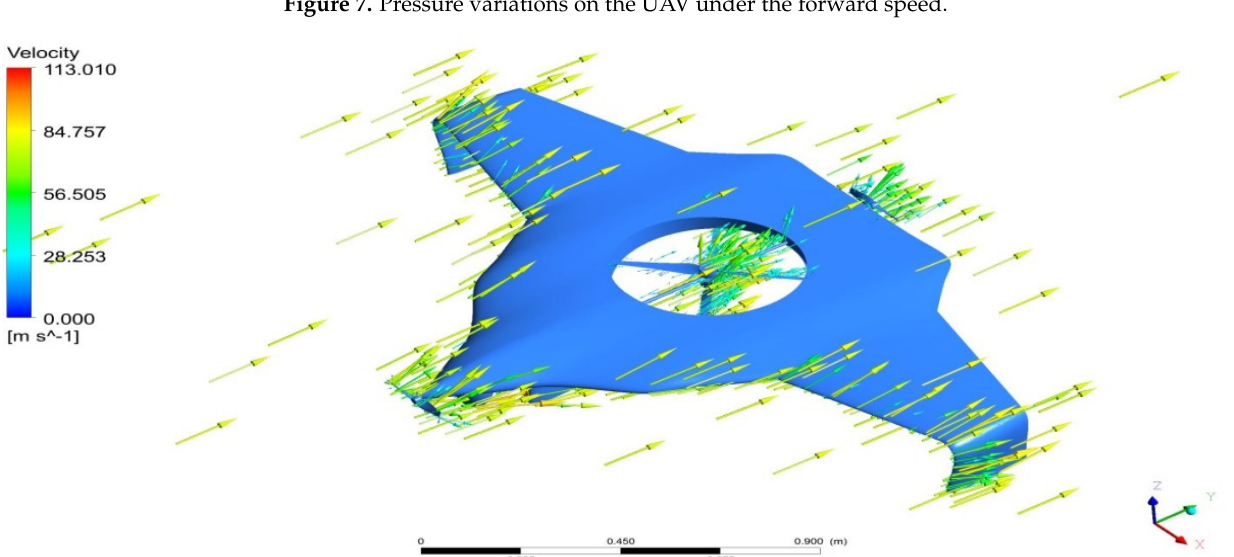
Figure 7. Pressure variations on the UAV under the forward speed.